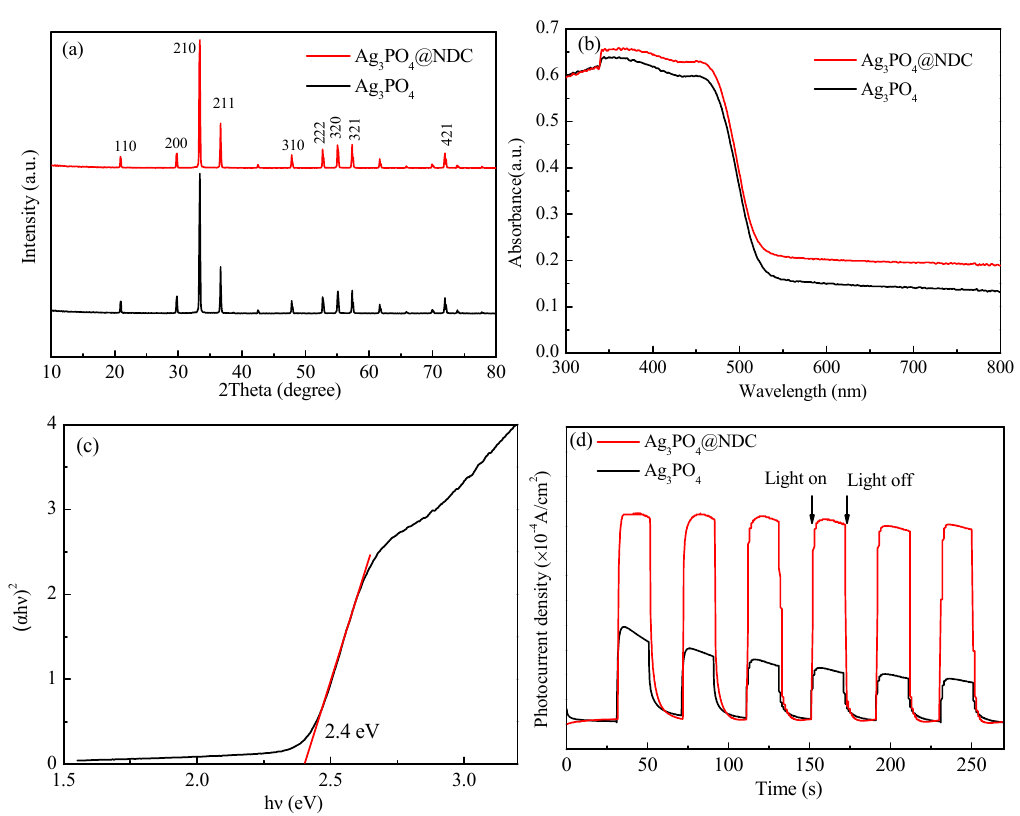
Figure 4. Ag 3 PO 4 and Ag 3 PO 4 @NDC XRD spectrum ( a ), UV Vis DRS spectrum ( b ), fitting curve ( c ), photocurrent response curve ( d ).